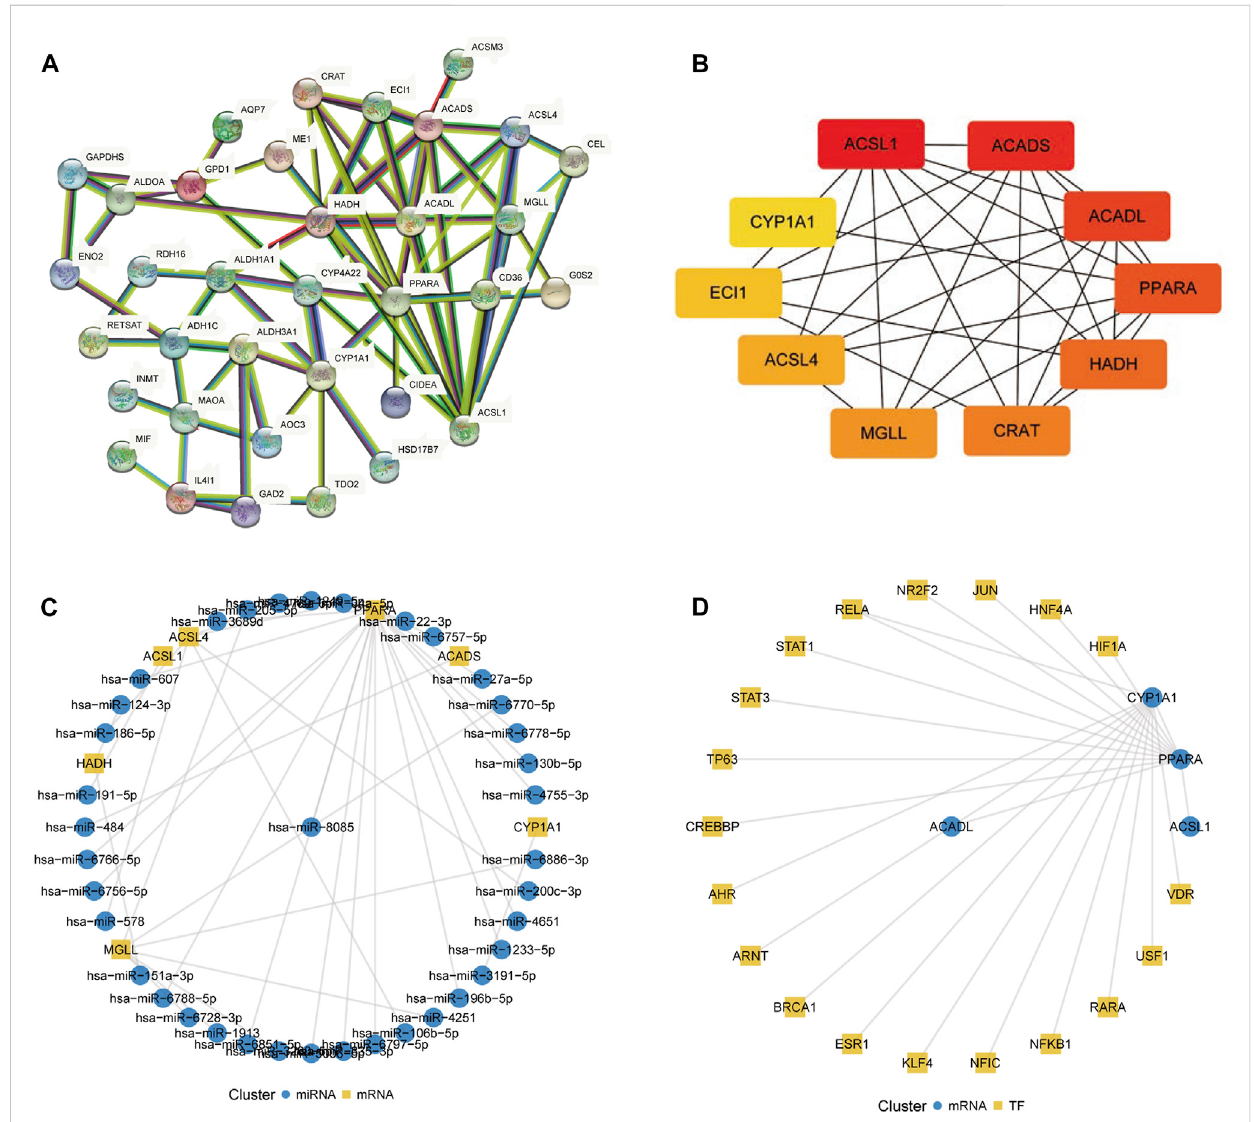
FIGURE 3 Construction of regulatory networks. (A) Protein – protein interaction network of fatty acid metabolism-related differentially expressed genes constructed using the STRING database. (B) Ten hub genes selected using the CytoHubba plugin. The color represents the gene MCC score, which ranges from 8 to 369, where the redder the color the higher the MCC score and the more orange the color the lower the MCC score. (C) mRNA – miRNA network constructed using the miRWalk database. (D) mRNA – transcription factor network constructed using the TRRUST